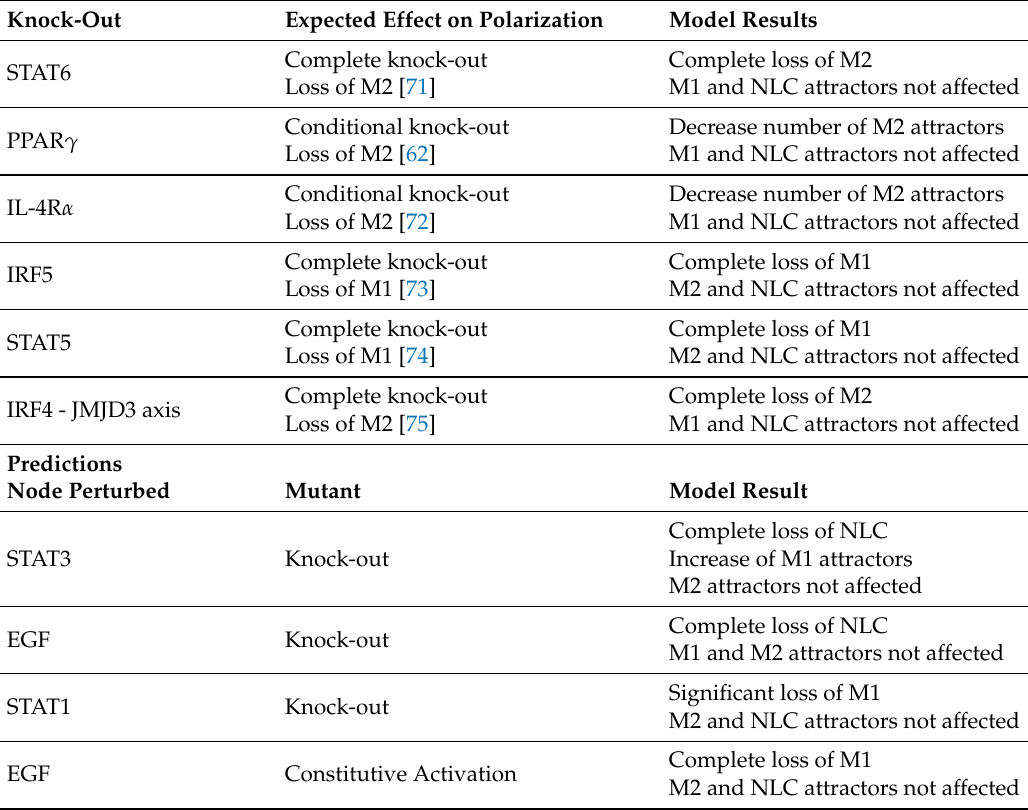
Table 4. In-Silico experiments with knock-outs and constitutive activations compared to experimental results